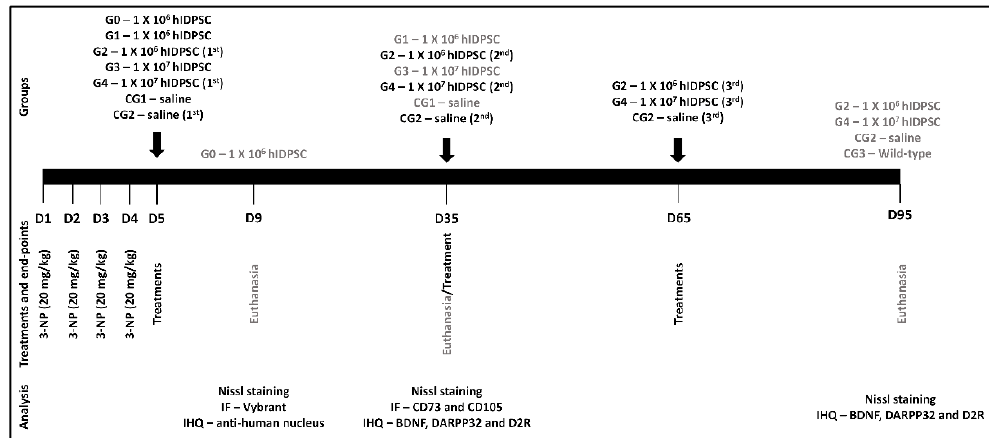
Figure 1. Schematic representation illustrating the study experimental design. 3-NP—3-nitropropi- Schematic representation illustrating the study experimental design. onic acid, D—Day, IF—immunofluorescence and IHQ—Immunohistochemistry.